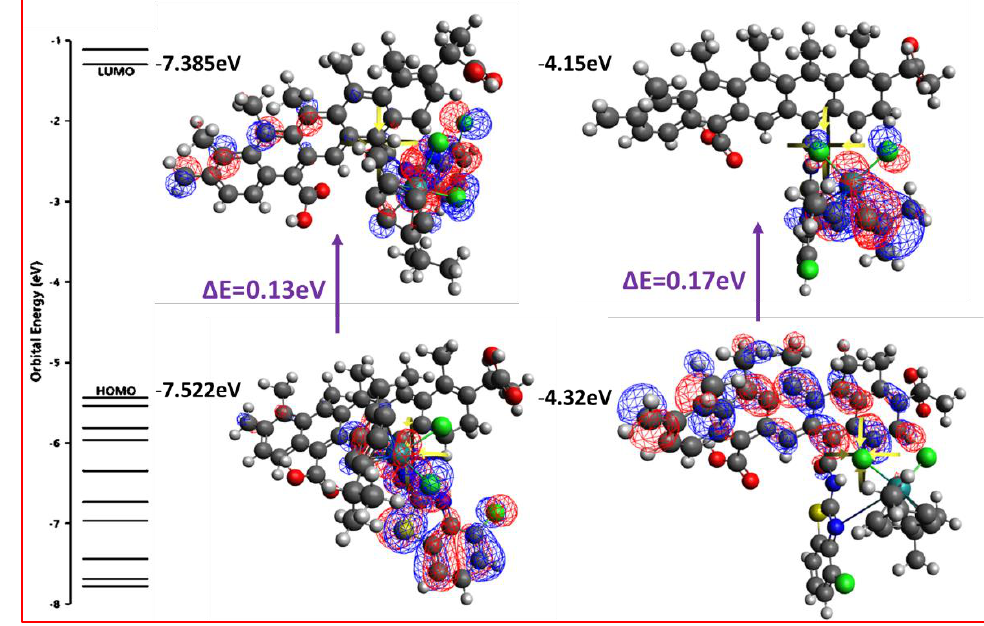
Figure 13. Frontier molecular orbital surfaces of GO-NCD- 1 and GO-NCD- 2.